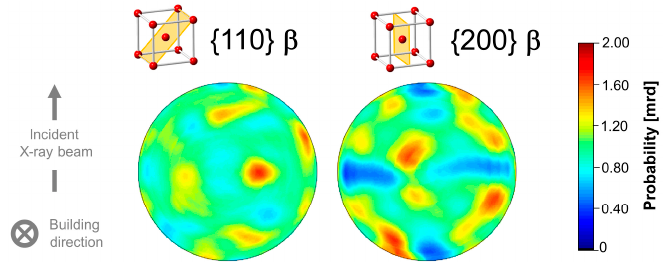
Figure 7. Color-coded pole figures of the crystallographic orientations {110} and {200} of β for the entire Ti-64 SLM sample reconstructed from the sum of the Debye–Scherrer rings acquired by HEXRD along the building direction z ( sample length = 10